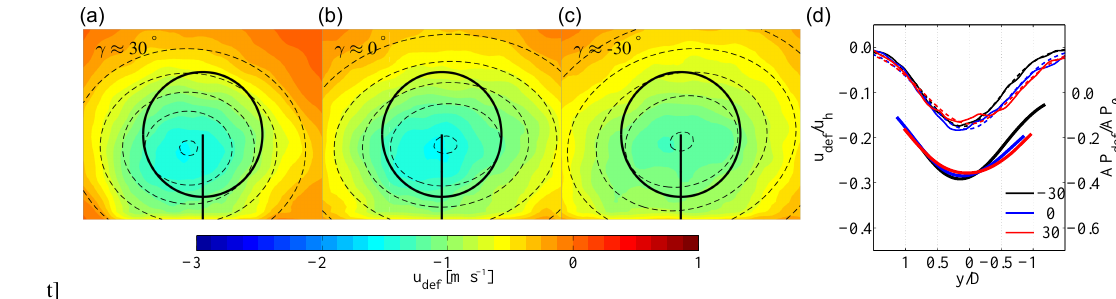
Figure 12. Same as in Fig. 5 but for the CBL simulation and for a time series of 60min.